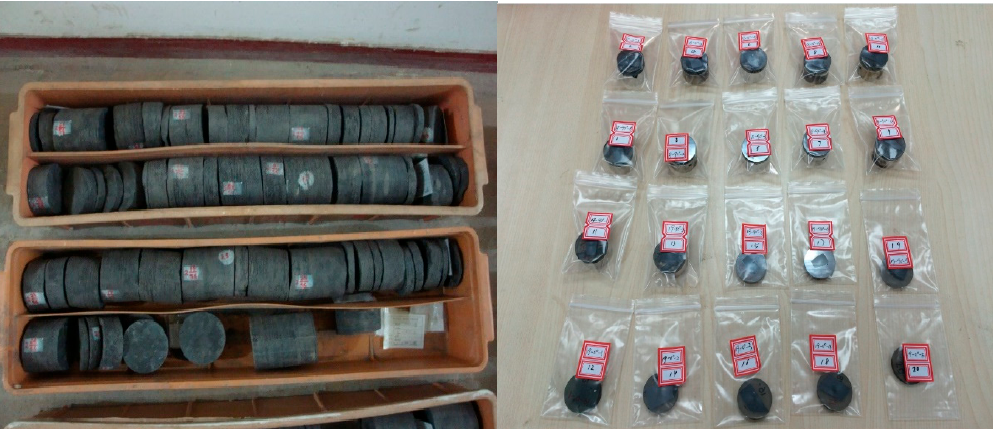
Figure 1. Samples from the Longmaxi Formation that were used in immersion tests.